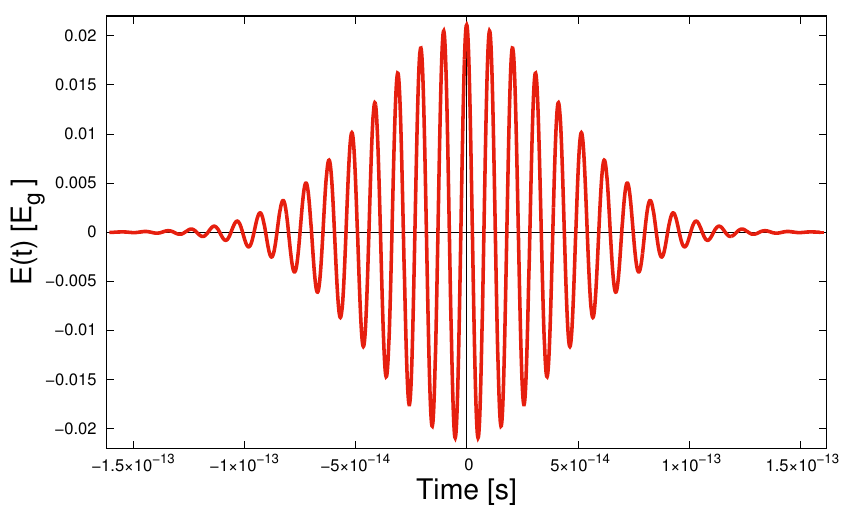
Figure 8. Time dependence of the field strength for the Gaussian envelope harmonic pulse (60) for E a = 2.2 10 2 V/ µ m, ω = 2 π ×